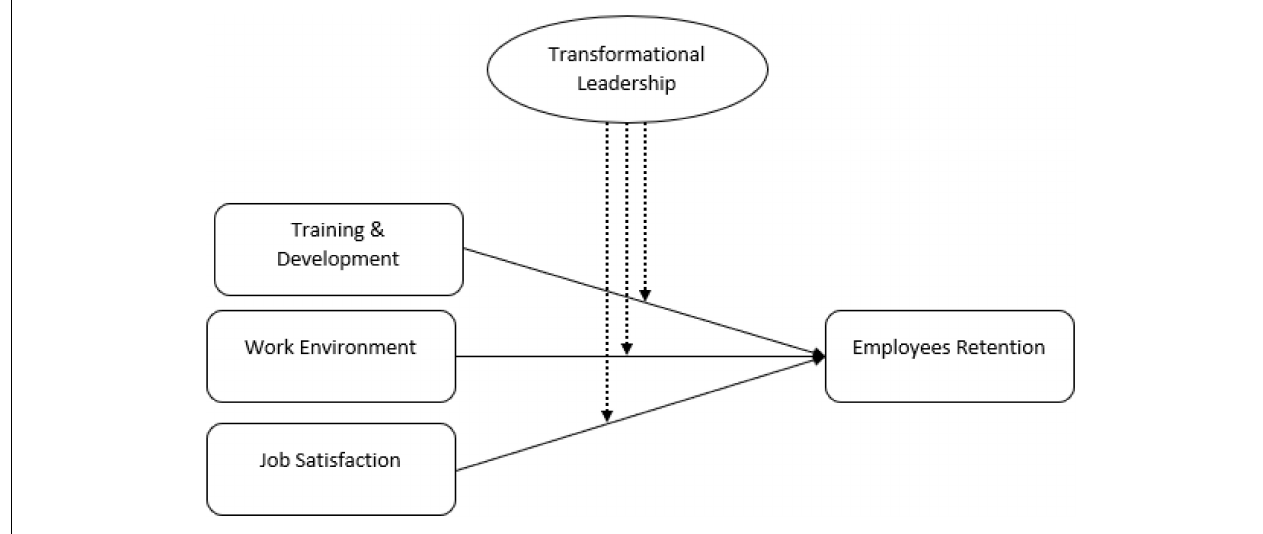
FIGURE 1 | Research